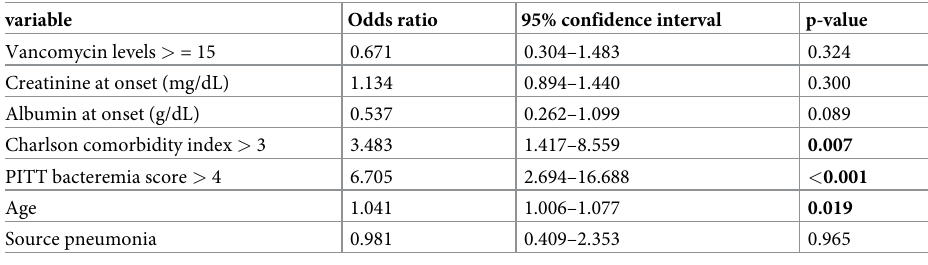
Table 4. Multivariate analysis of risk factors for mortality among 162 PS-matched patients.